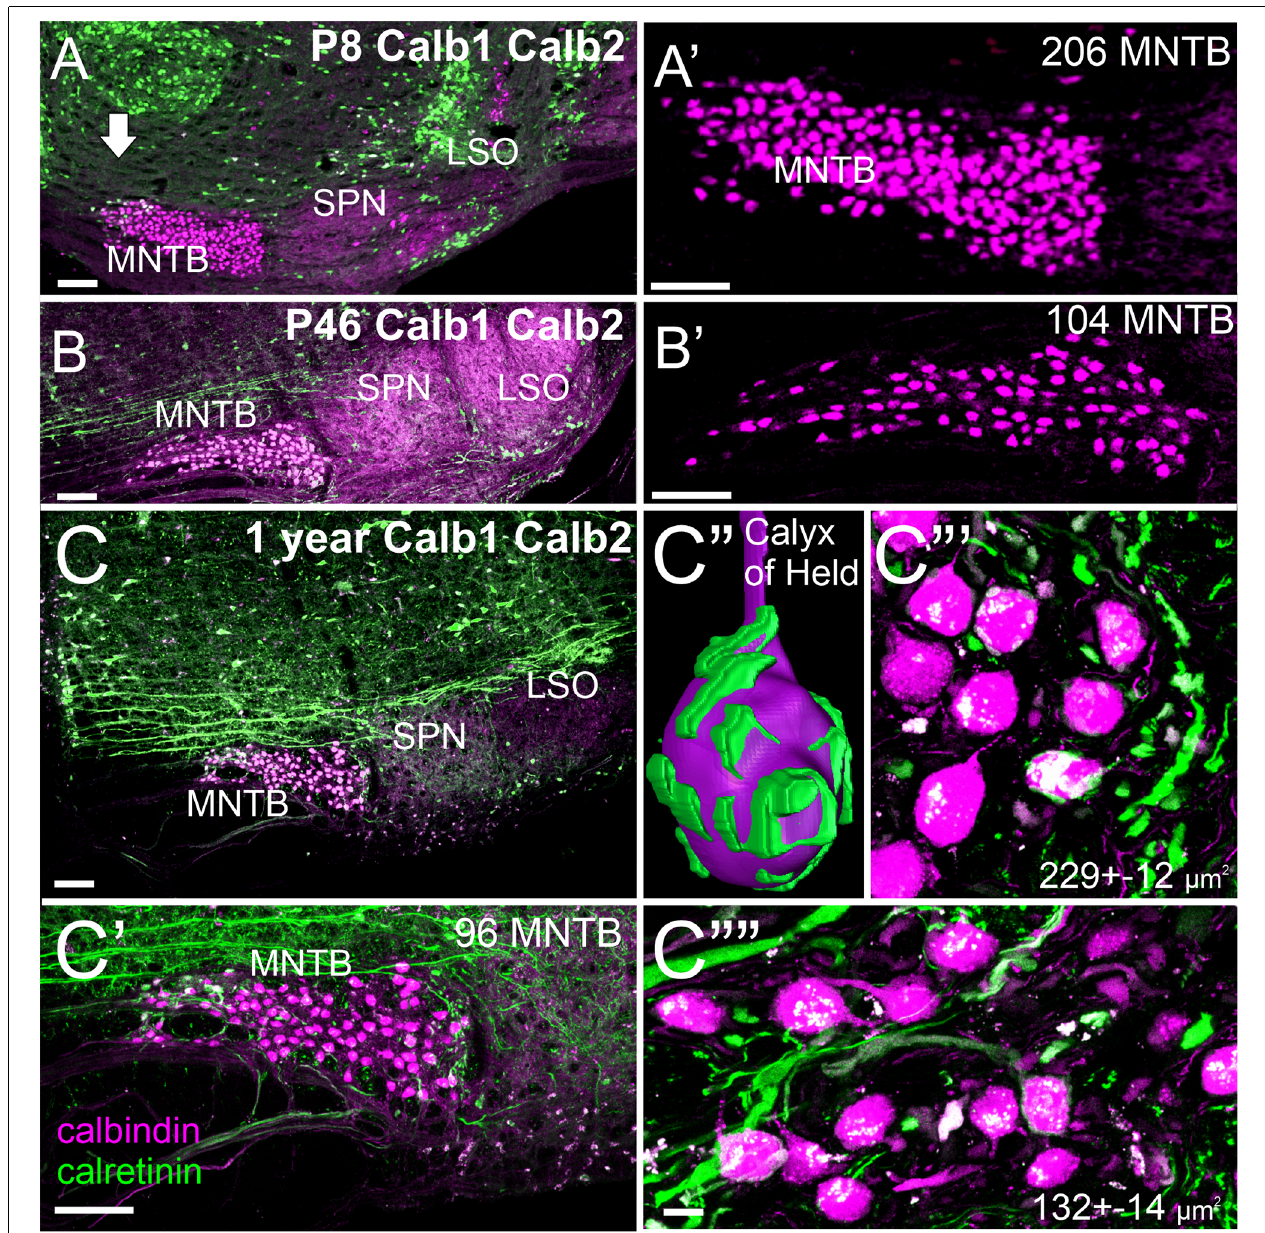
FIGURE 4 | Early expression of Calbindin ( Calb1 ) and Calretinin ( Calb2 ) expression in the MNTB at P8 (A,A’) . Calb1 expression increases in the LSO by P46 (B,B’) . At 1 year of age, there is minimal Calb1 expression in the LSO and SPN. Calb2 -positive fibers form a calyx of Held in the MNTB (C–C””) . Within the MNTB, there are larger Calb1 -positive cells close to the cochlear nucleus ( ∼ 229 µ m 2 ) compared to much smaller cells closer to the midline ( ∼ 132 µ m 2 ). Our expression shows upregulation of Calb2 in the MNTB (compare P8 with P46) that progressively upregulates with Calb1 . Note that fewer MNTB are shown in a single section that likely comes about through lateral distributions. P: postnatal, Bar indicates 100 µ m in (A–C,C’) , 10 µ m in (C”’,C””)